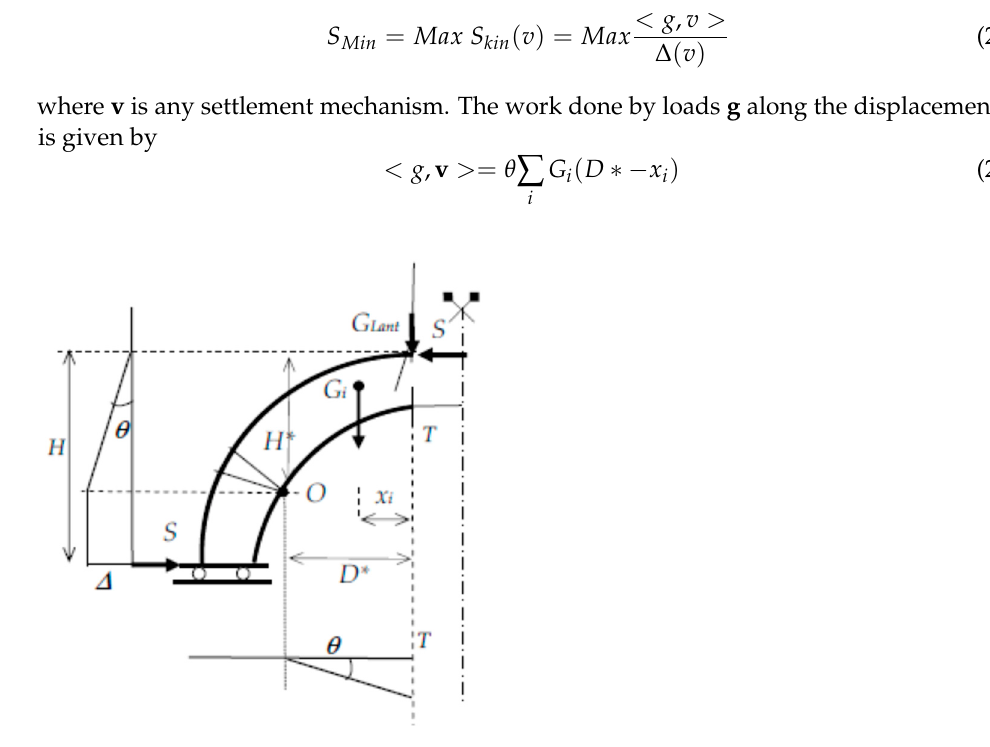
Figure 7. The minimum thrust evaluated via the kinematic approach.